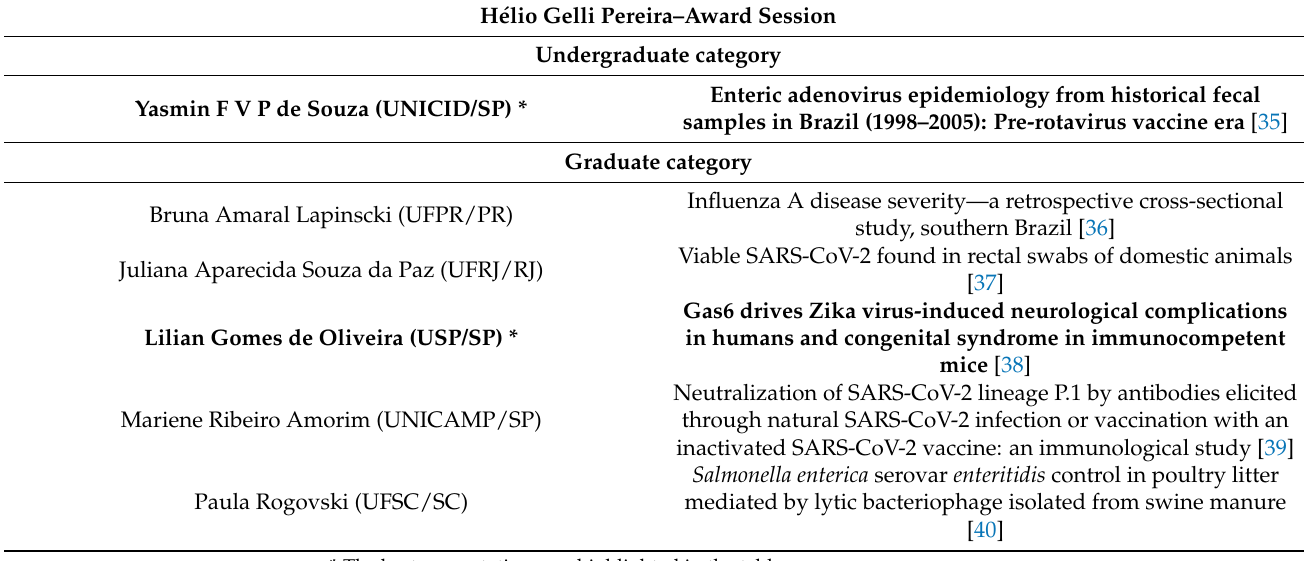
Table 3. Oral presentation on the HGP